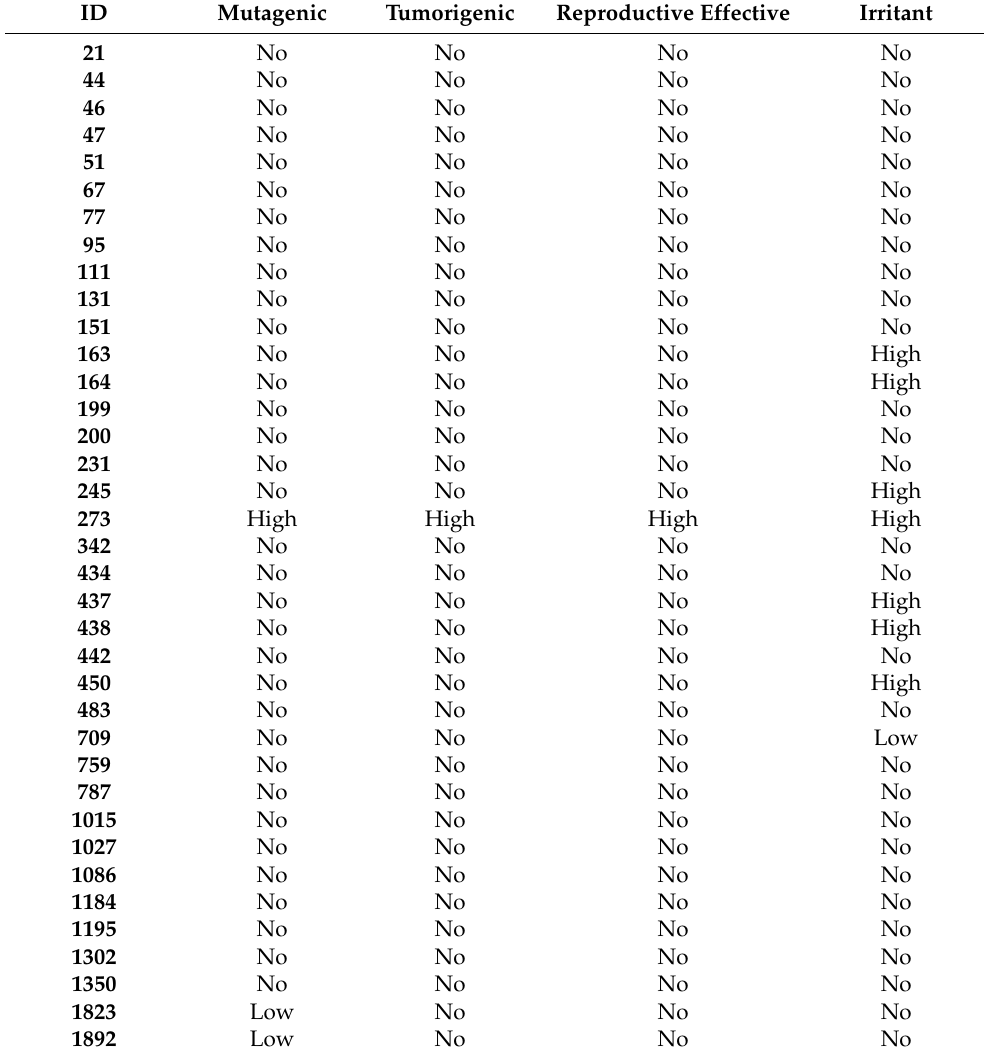
Table 9. Toxicity evaluation of compounds considered active and multitargeting for D. melanogaster . ID Mutagenic Tumorigenic Reproductive Effective Irritant